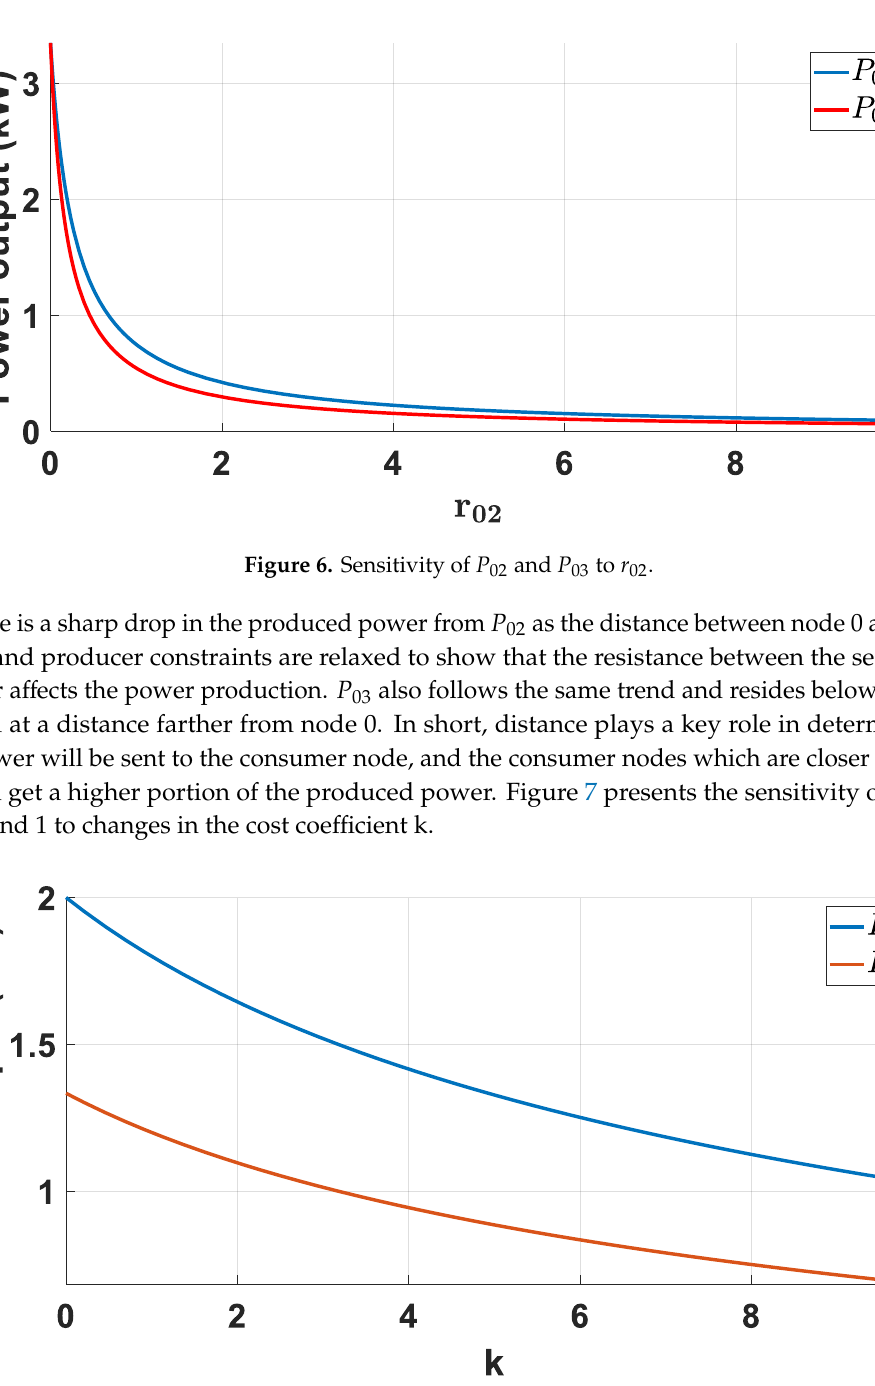
Figure 8. Sensitivity of 𝑃 02 and 𝑃 03 to α . This parameter shows the nodal price of electricity at the distribution transformer. When the producers start to output power, the price declines with the slope of β, as shown in (12). As the initial price of electricity increases, the revenue of sellers increases accordingly and as a result, they are incentivized to produce more power. The produced power is limited by the amount of power available from the sellers. 𝑃 03 has a lower value compared to 𝑃 02 because it is located farther from producer 0. Figure 9 shows the sensitivity of sellers to the slope of electricity price. With very low